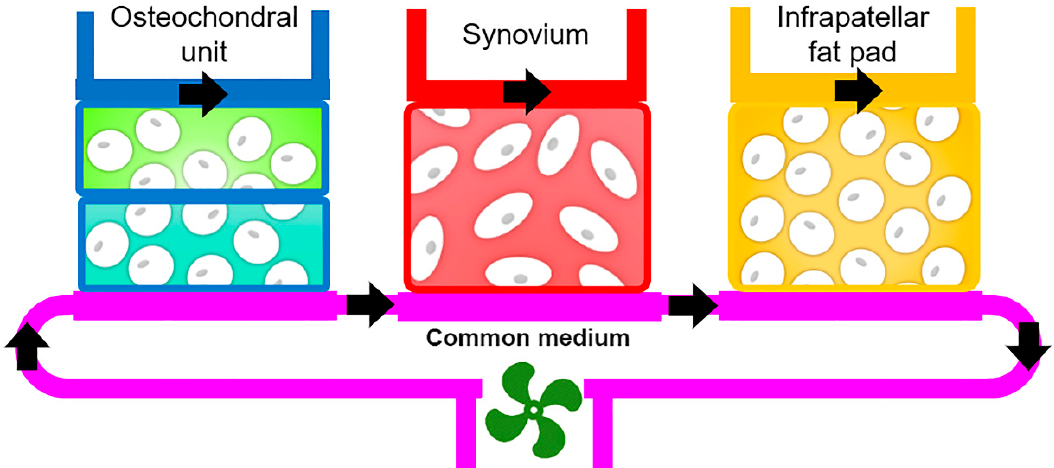
Figure 4. Design of a microphysiological system that simulates the in vivo crosstalk among bone, cartilage, synovium, and infrapatellar fat pad tissues. Each engineered tissue is connected to other tissues through either microfluidics or diffusion, and can thus interact with one another in a real-time manner. The plug-and-play design allows assessment of the contribution of each joint component in the process of OA pathogenesis. Table 3. Advantages and disadvantages of current in vitro models for OA research.